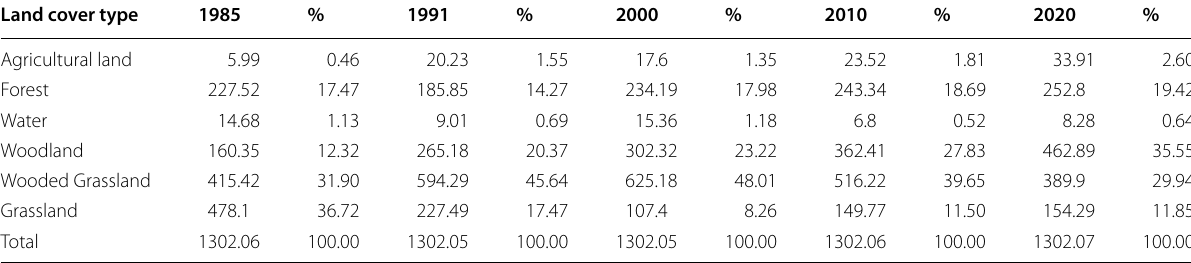
Table 1 The land use-land cover types of each year (in km 2 and %) of within the park areas of the CCNP Land cover type